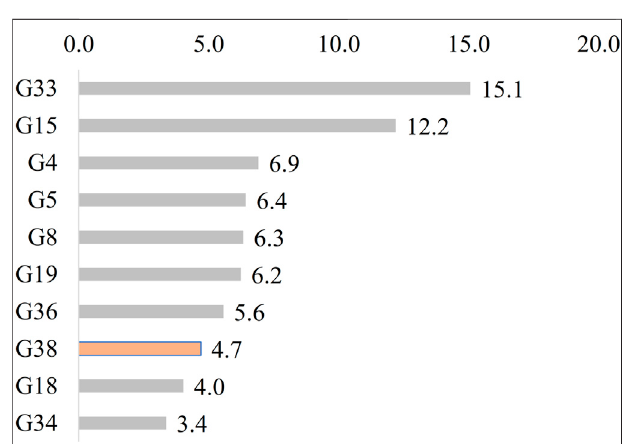
FIGURE 10 | Most cited ailment categories according to Dioscorides. Leprosy (G38) is only reported in Dioscorides.